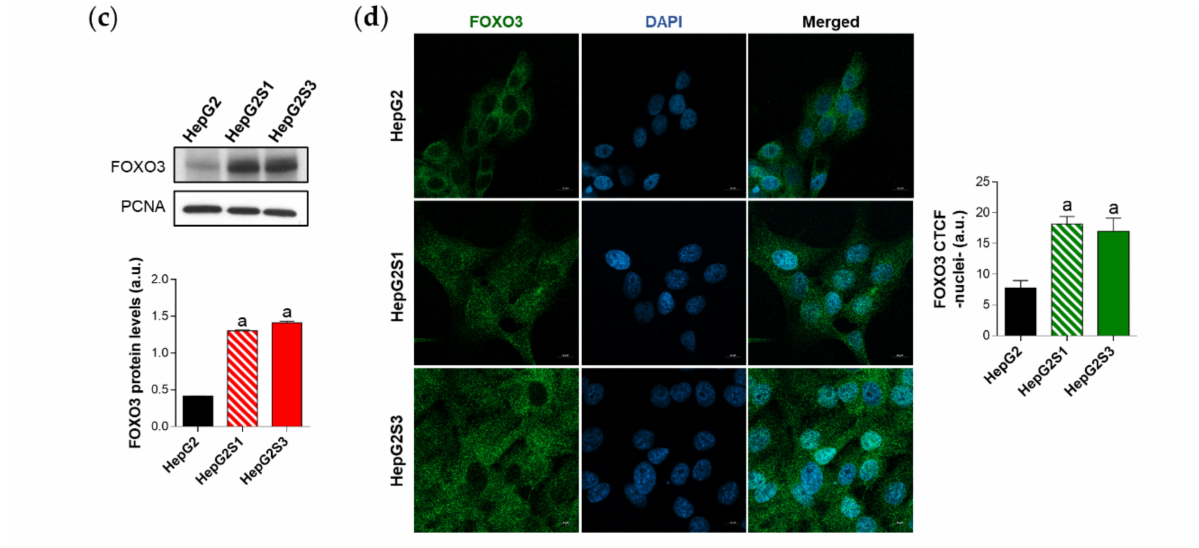
Figure 3. Characterization of forkhead box O3 (FOXO3) expression in HCC patient samples and sorafenib-resistant HCC in vitro models. ( a ) Comparison of FOXO3 expression between HCC and normal liver tissues. p < 0.05 significant differences between groups; ( b ) Impact of FOXO3 expression on HCC patient survival rate. p < 0.05 significant differences between high (red) and low/medium (blue) FOXO3 levels; ( c ) Immunoblots from the in vitro analysis of FOXO3 expression. Densitometry reading of each band is shown; ( d ) Evaluation of FOXO3 nuclear translocation employing confocal microscopy and FOXO3 immunofluorescence. Green fluorescence, FOXO3. Blue, cell nucleus. Magnification 63 × , scale bar 10 µ m. Bar graph from the quantification of nuclear green fluorescence (FOXO3) is also shown. Data from ( c , d ) are expressed as mean values of arbitrary units (a.u.) ± SD of three independent experiments. a p < 0.05 vs. HepG2